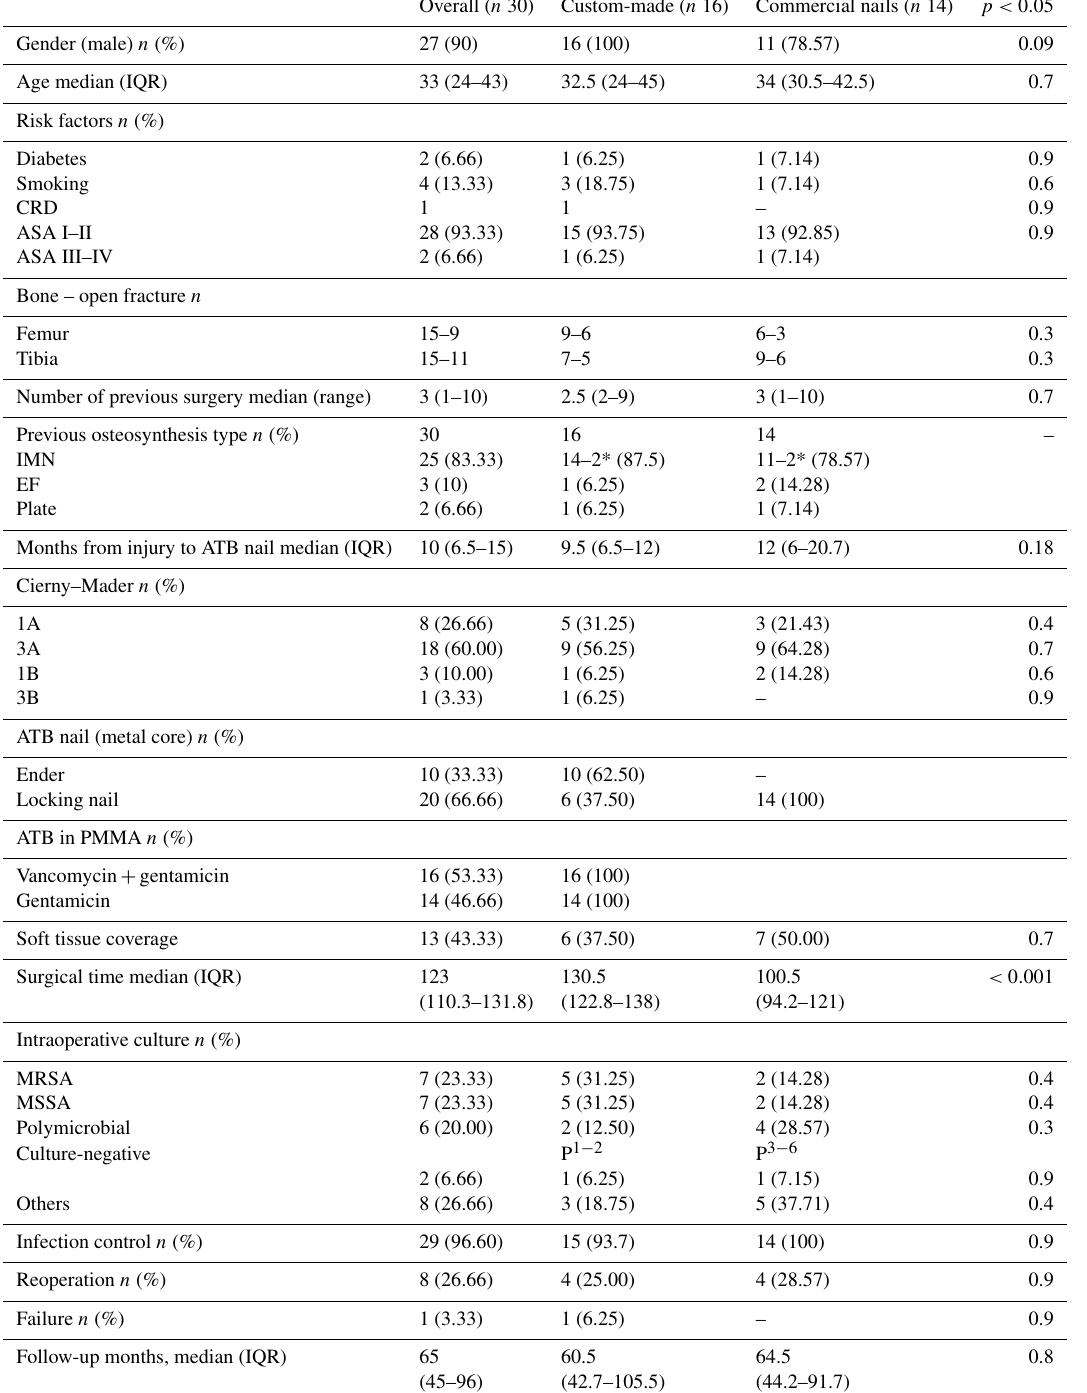
Table 2. Comparative analysis between patients treated with custom-made and commercial